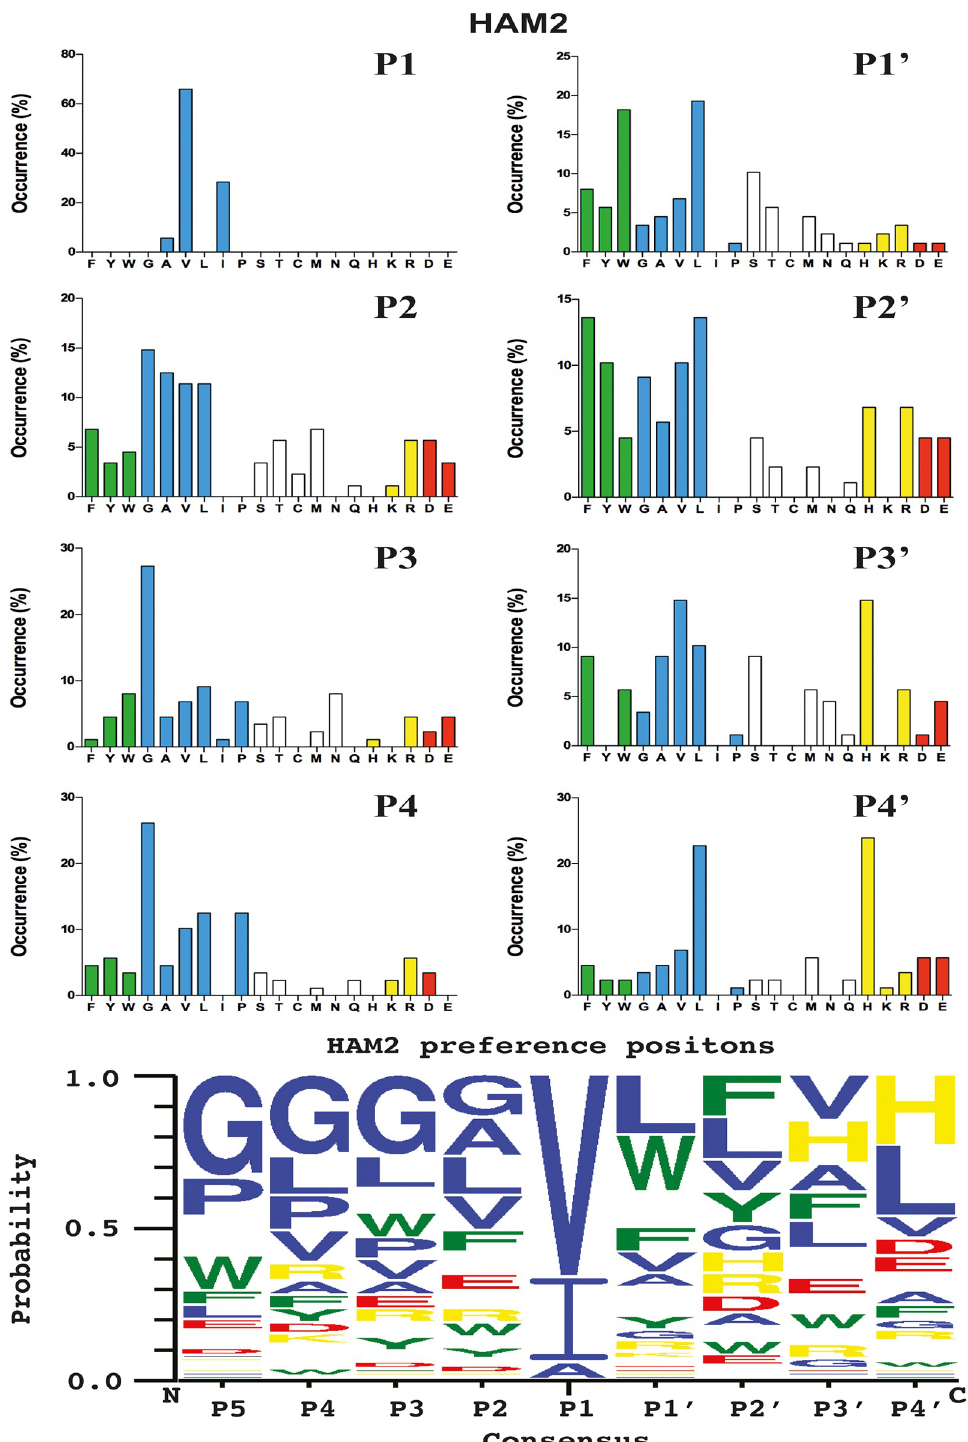
Fig 7. Distribution of amino acids in positions P4 to P4´ in phage displayed nonamers cleaved by HAM2 after five biopannings. Based on the alignment in Fig 6 the percentage of each amino acid present in each position P4 to P4´ as calculated. The amino acids are ordered from left to right: aromatic, aliphatic, hydrophilic, basic (positively charged) and acidic (negatively charged). In the bottom of the figure we have used the computer program WebLogo to generate an illustration of the relative distribution of the amino acid preferences for cleavage by HAM2 as obtained from the phage display analysis.